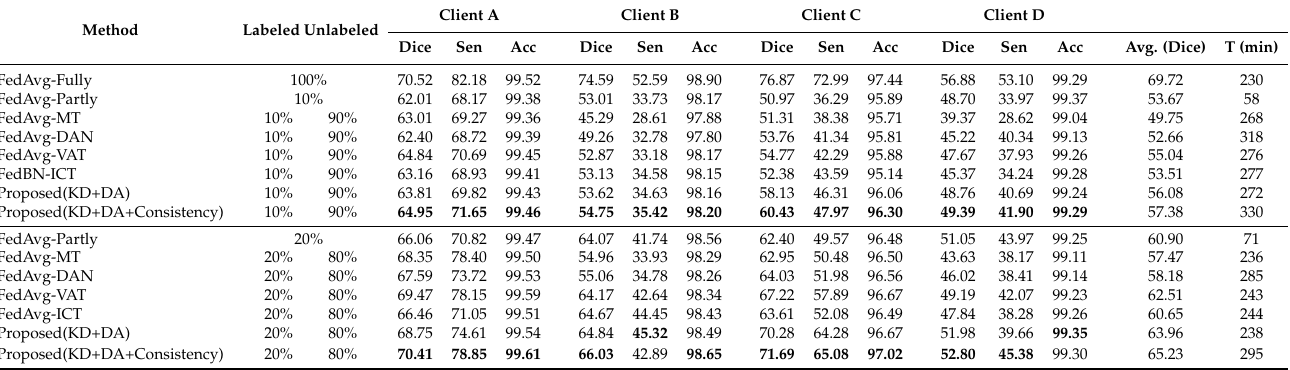
Table 3. Comparison with a naive combination of some semi-supervised methods and FedAvg, using limited labeled data on multi-national COVID-19 lesion